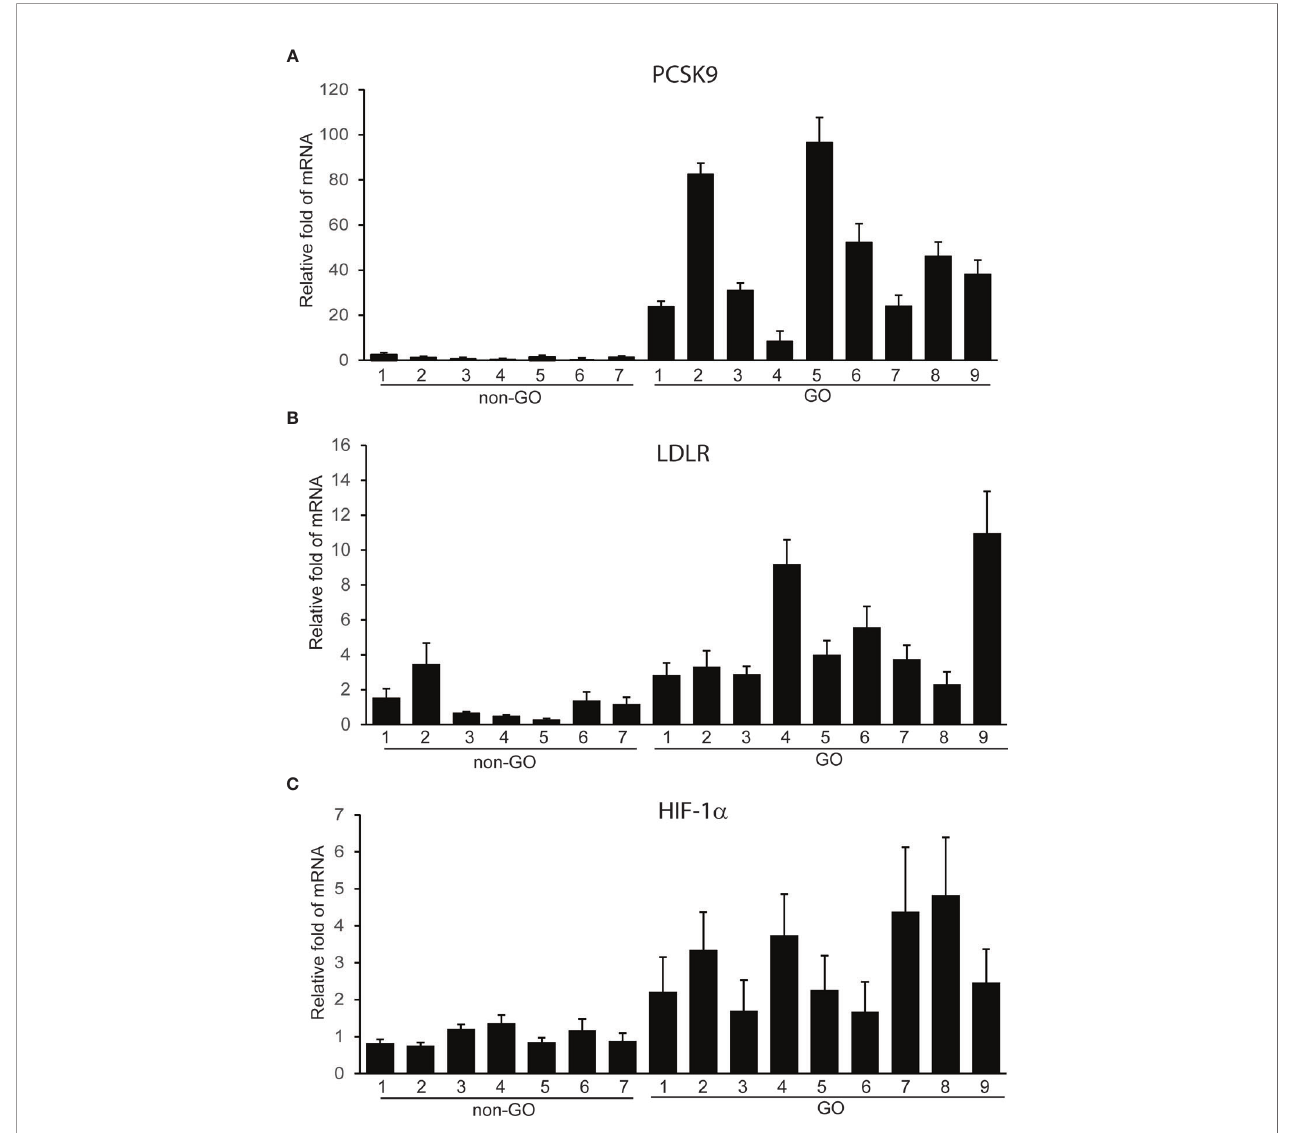
FIGURE 1 | Expression of proprotein convertase subtilisin/kexin type 9 (PCSK9), low density lipoprotein receptor (LDLR), and hypoxia-inducible factor 1a (HIF-1a) mRNAs in Graves ’ orbitopathy (GO) and non-GO orbital tissues. The RNA extracted from GO (n=9) and non-GO (n=7) orbital tissues was reverse-transcribed by real-time PCR and quanti fi ed. Experiments were performed in triplicate for each donor. The results showed elevated transcript levels of PCSK9 (A) , LDLR (B) , and HIF-1a (C) in GO tissues than in non-GO tissues. Data in the column indicate the mean ± SD fold elevation relative to the